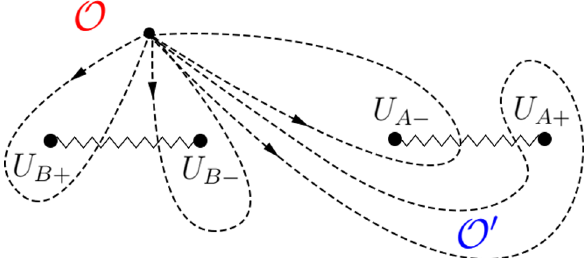
Figure 22 . The monodromies associated with the nodes in the 5d BPS quiver. The 3rd and the 4th paths become simple when we move from O to O 0 which amounts to the motion from the first saddle to the second, adopted in section 3 above. These paths differ from those of ref. [18], which explains the difference in the resulting